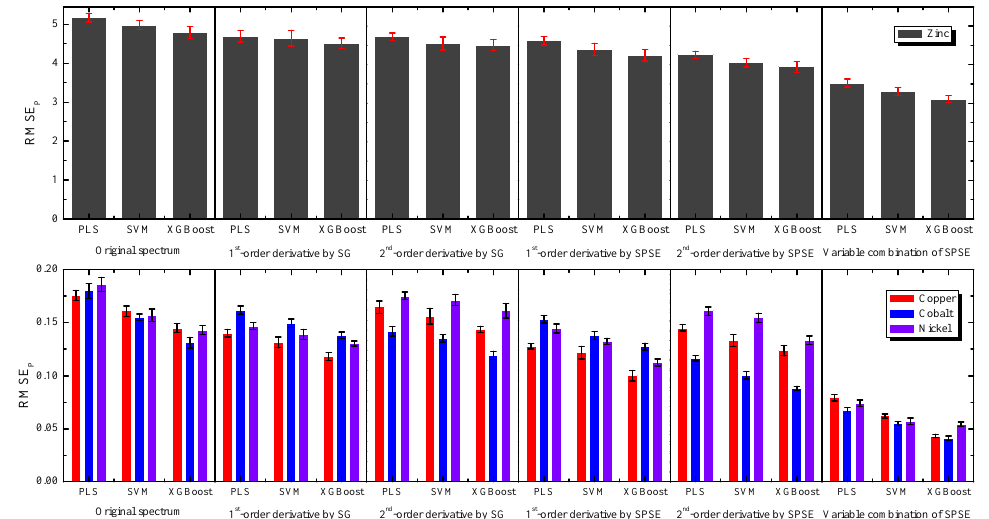
Figure 8. Comparison results among different preprocessing and modeling methods for zinc, copper, cobalt, and nickel